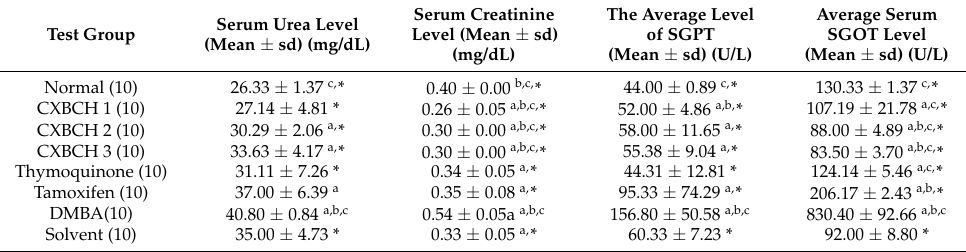
Table 3. Results of examination of blood urea and creatinine levels of DMBA-induced SD rats after receiving CXBCH treatment two weeks before and five weeks during DMBA induction. Blood sampling was carried out at the 30th week of the experiment. Serum Creatinine Test Group Serum Urea Level (Mean ± sd) (mg/dL) Level (Mean ± sd)